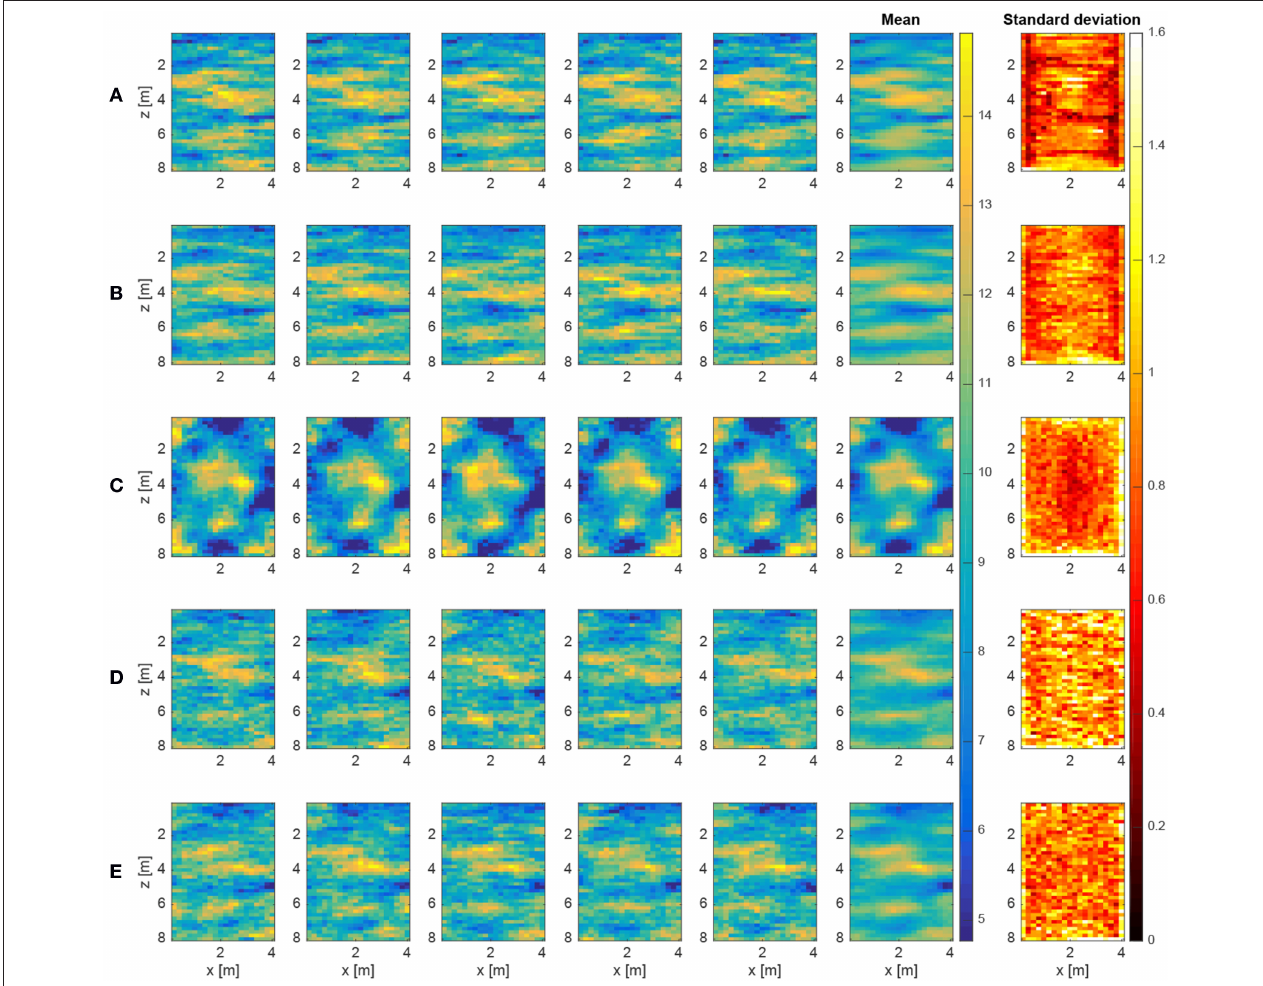
FIGURE 6 | Five randomly chosen posterior slowness realizations along with the point-wise mean and standard deviation [ns/m] obtained via (A) MCMC sampling based on the detailed eikonal solver (140 samples total); (B) standard ES-MDA based on the detailed eikonal solver with n e (C) standard ES-MDA based on the proxy straight-ray solver with n e n d 20, and n e 160 ( Figure 4 ; 1,600 samples total); and (E) our modified ES-MDA procedure with 40 KNN, n d = =